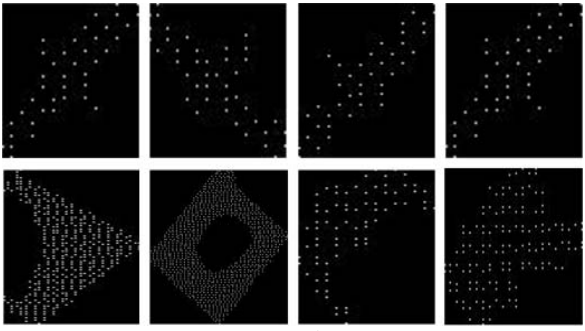
Figure 6. Depth images of the clustering